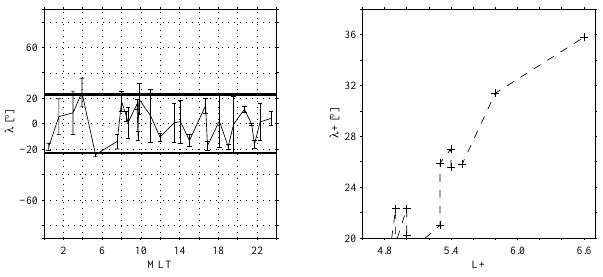
Fig. 6. Left panel: magnetic latitude ranges vs. MLT; right panel: magnetic latitude upper absolute value vs.